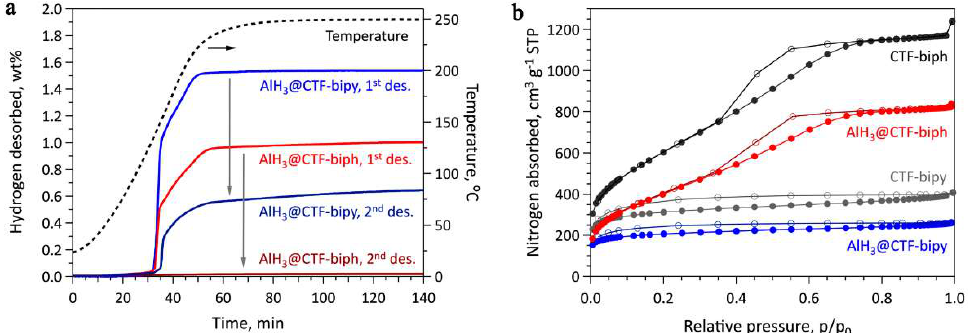
Figure 18. ( a ) Sievert data for CTF-based supported alane; ( b ) N 2 sorption isotherms at 77 K for CTF-biph, AlH 3 @CTF-biph, CTF-bipy, and AlH 3 @CTF-bipy. Reprinted/adapted with permission from Ref. [51]. 2021, Wiley-VCH GmbH.